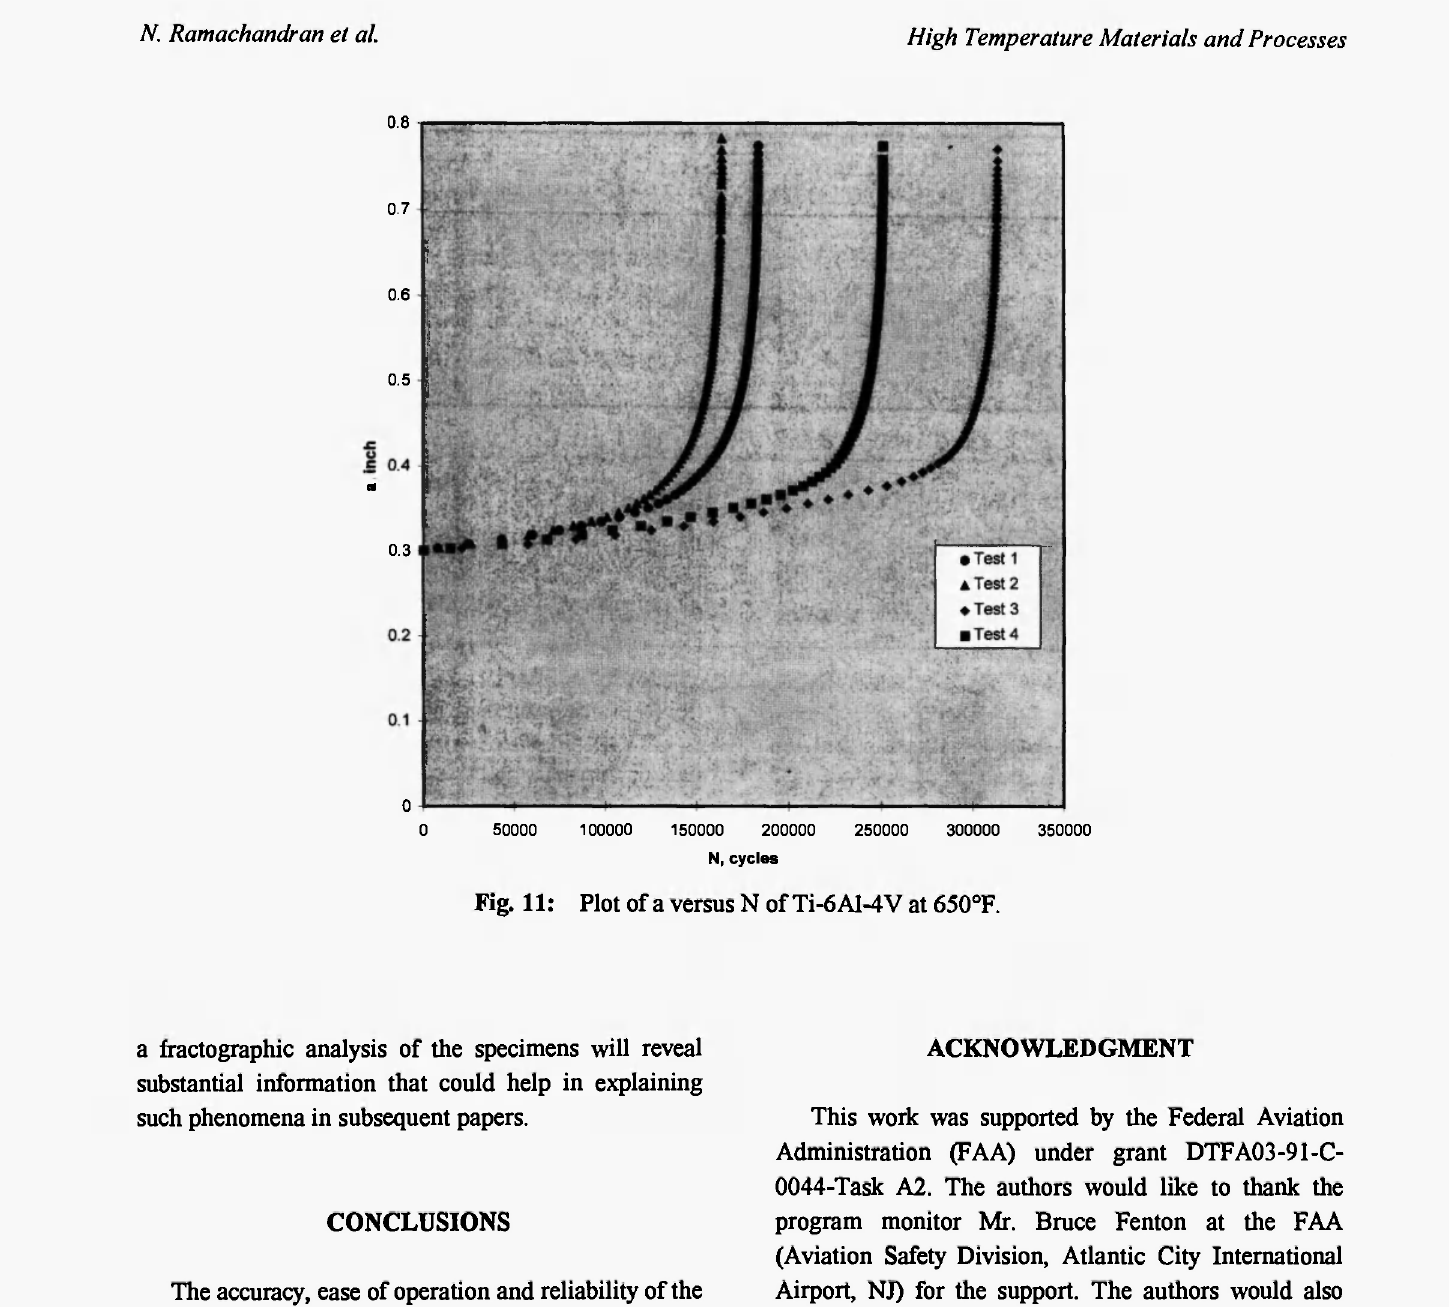
Fig. 11: Plot of a versus Ν of Ti-6A1-4V at